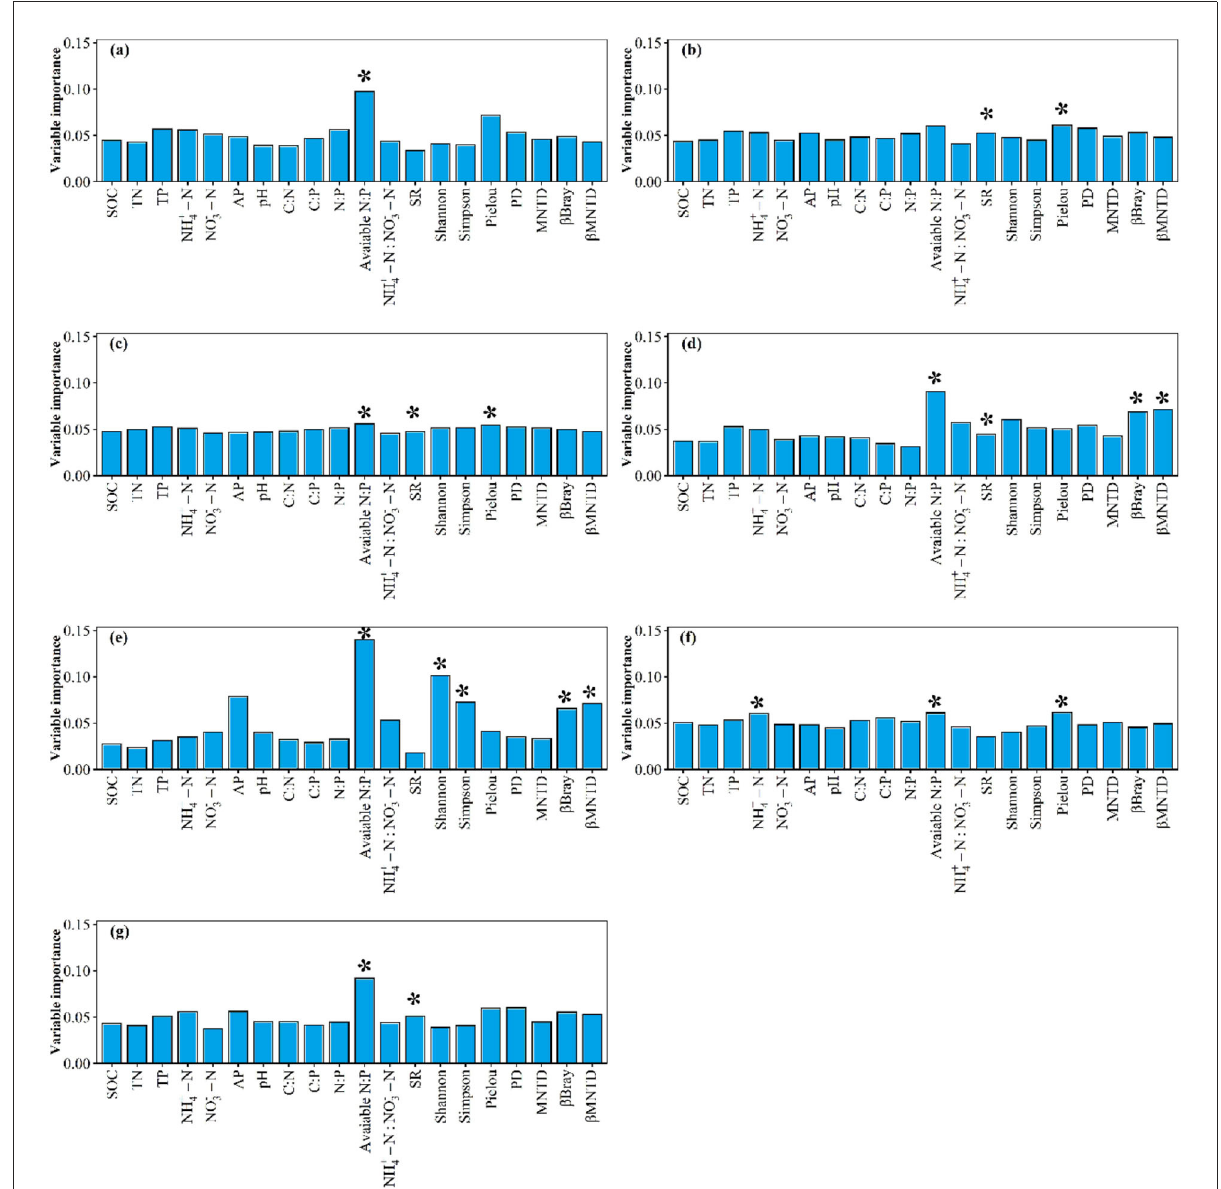
FIGURE6 The relative contributions of α - and β -diversity of plant community and soil variables for plant community (a) crude protein storage, (b) acid detergent fiber storage, (c) neutral detergent fiber storage, (d) ether extract storage, (e) crude ash storage, (f) water-soluble carbohydrates storage, and (g) nutrient storages, respectively. * indicates p <